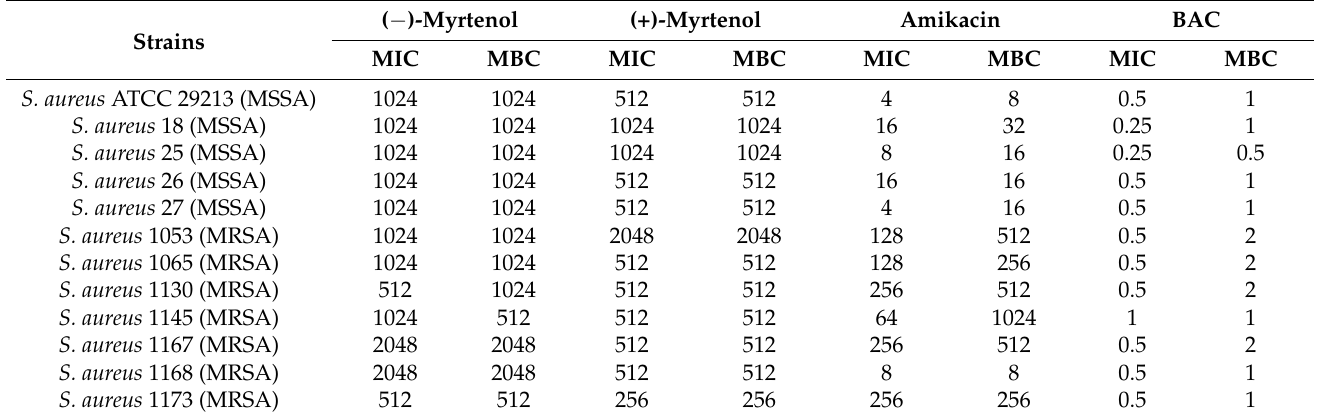
Table 1. Minimum inhibitory concentration (MIC) and minimum bactericidal concentration (MBC) values (expressed in µ g/mL) of ( − )-myrtenol, (+)-myrtenol, amikacin, and benzalkonium chloride (BAC) against S. aureus isolates.